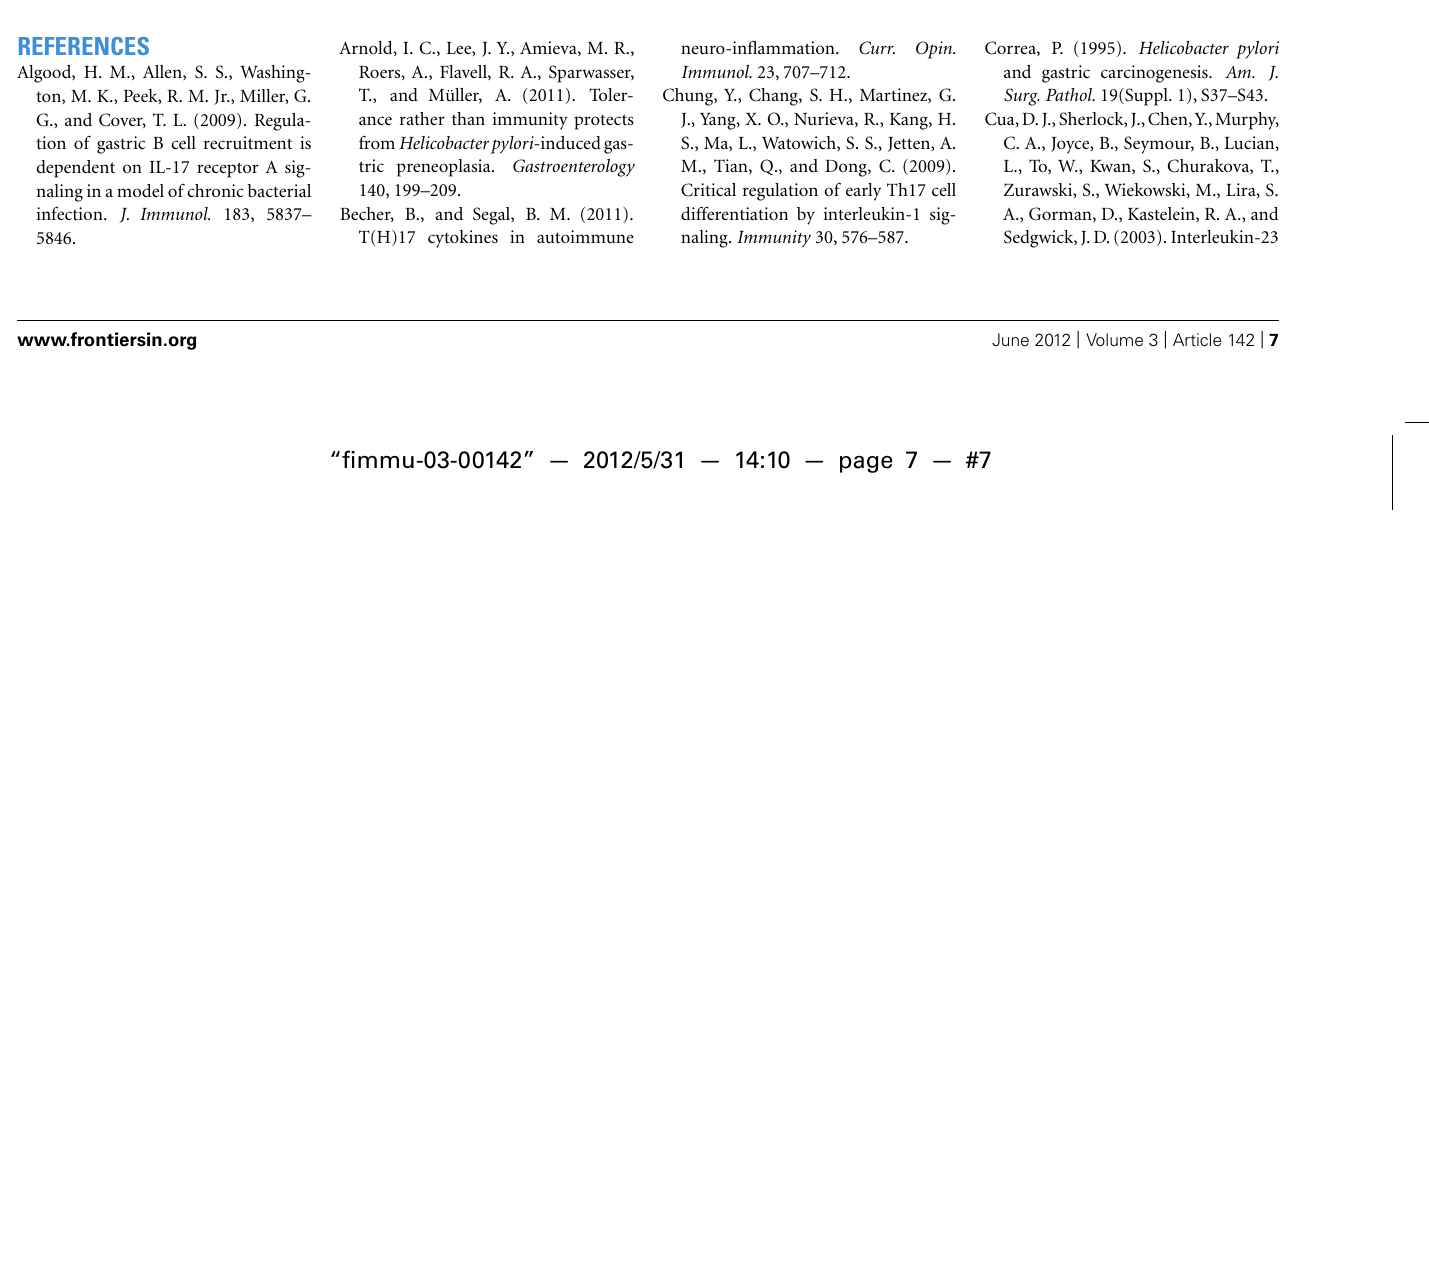
FIGURE 4 | IL-23p19 − / − and IL-12p35 − / − mice do not differ significantly from wild type animals with respect to H. pylori infection control; infection-associated immunopathology is reduced in IL-23p19 − / − mice. (A) Colony forming units (CFU) as determined by plating and colony counting of wild type (WT; n = 9), IL-23p19 − / − ( n = 13), and IL-12p35 − / − ( n = 15) mice